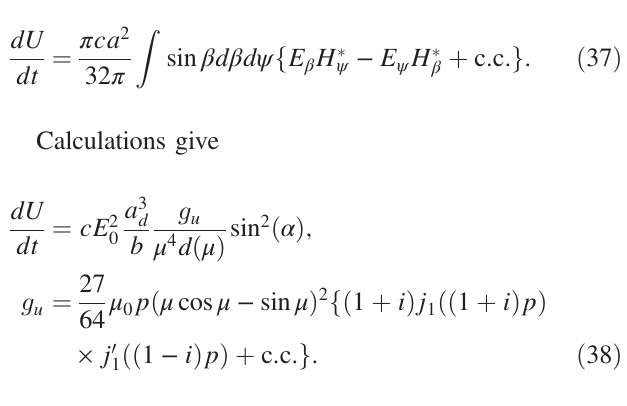
FIG. 8. The same as in Fig. 7 with p ¼ 5 . 0 .